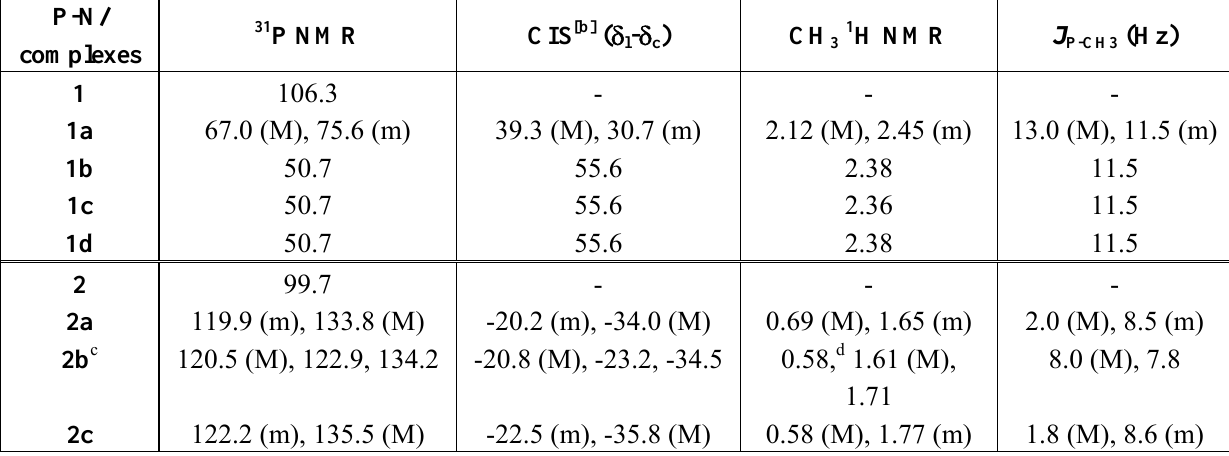
Table 1. Selected chemical shift values for the ligands and the relevant palladium complexes. [a]